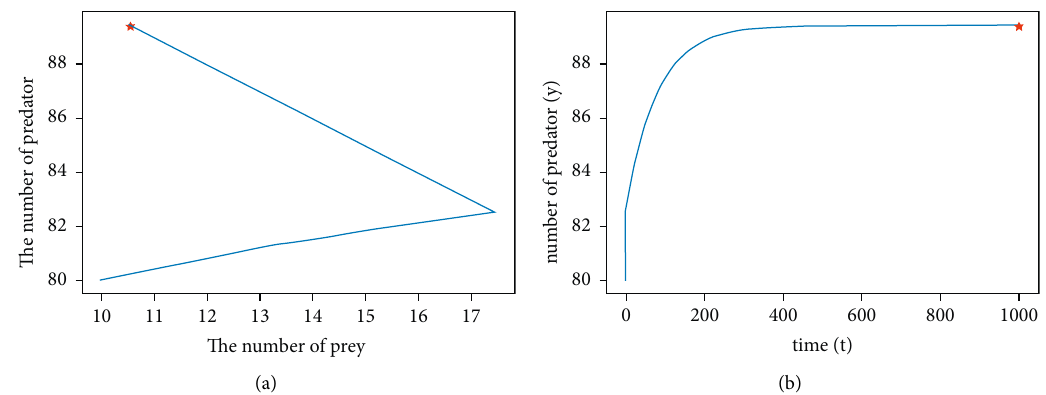
Figure 3: Nondelay case, τ � 0. (a) The phase portrait; (b) the number of predators converging to the equilibrium